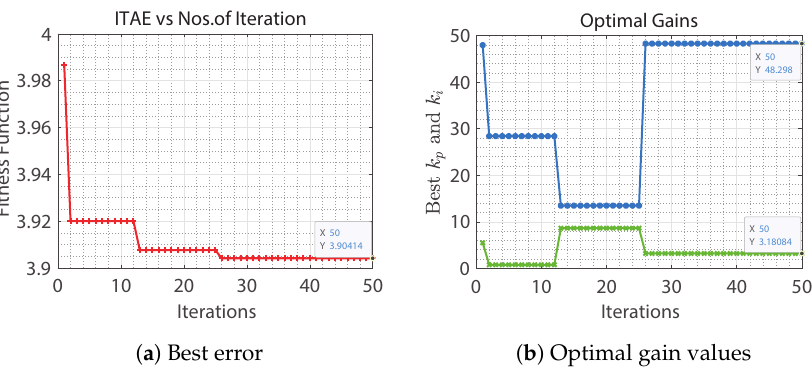
Figure 2. Cuckoo search algorithm for speed control